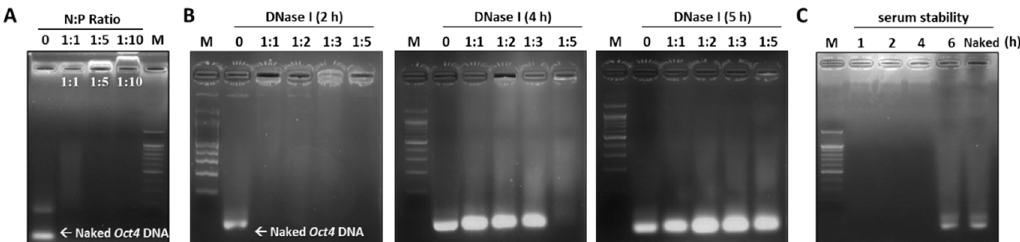
Figure 3. Gel retardation and serum stability assays of the Oct4 -LMWP complex. To determine the optimum N:P molar ratio of complexes, ( A ) Oct4 DNA and LMWP were mixed at different molar ratios and analyzed by gel retardation with 1% agarose gel electrophoresis. ( B ) The DNase I protection and ( C ) serum (50%) stability of the Oct4 -LMWP complex (N:P = 1:5) were evaluated using an agarose gel retardation method at the indicated time points. M: size